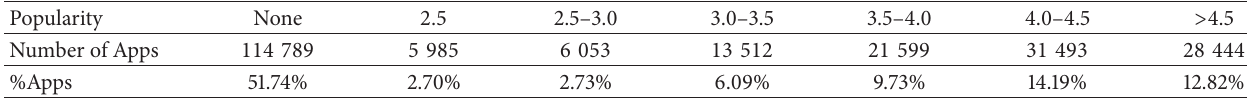
Table 1: Initial distribution of Apps by popularity in July 2011 .